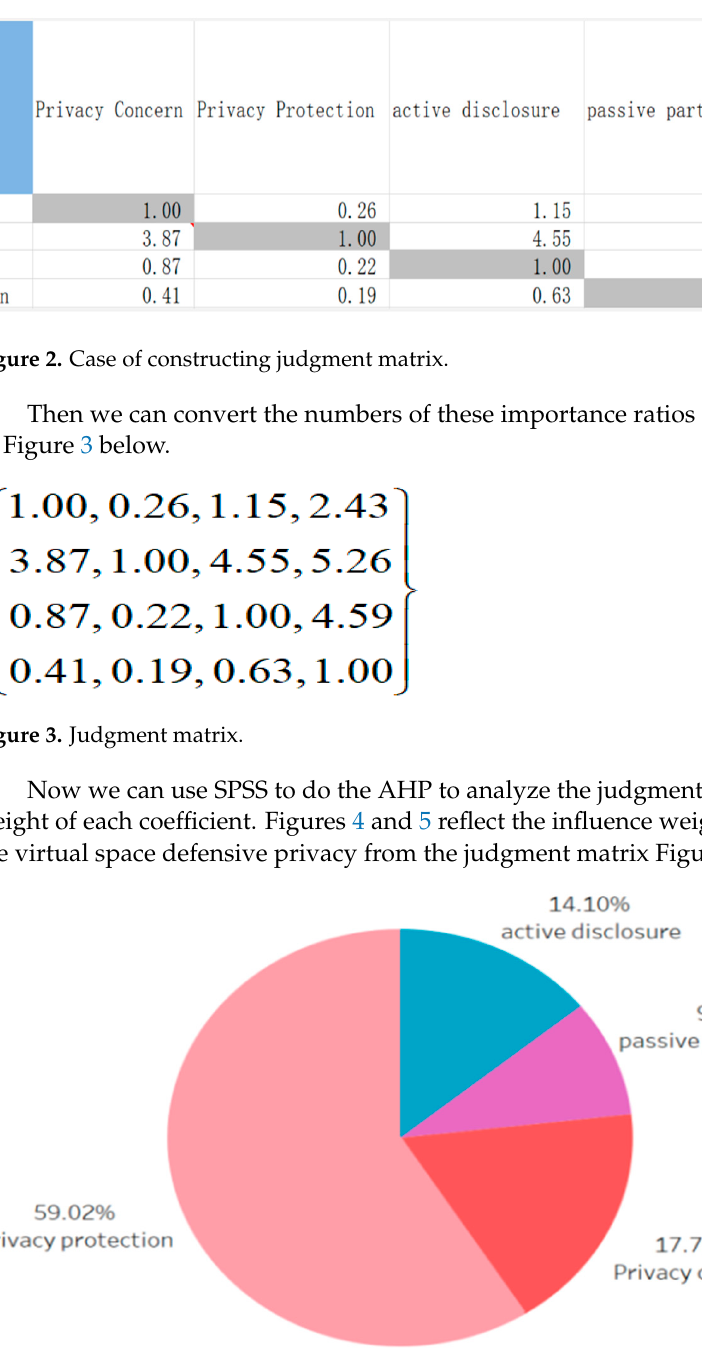
Figure 5. Multi-level weight graph.